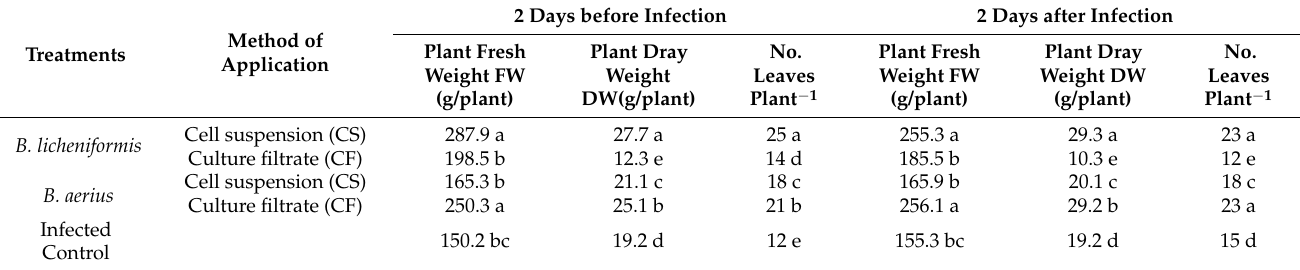
Table 5. Effect of Bacillus licheniformis and B. aerius treatments on fresh and dry weight of cucumber plants.